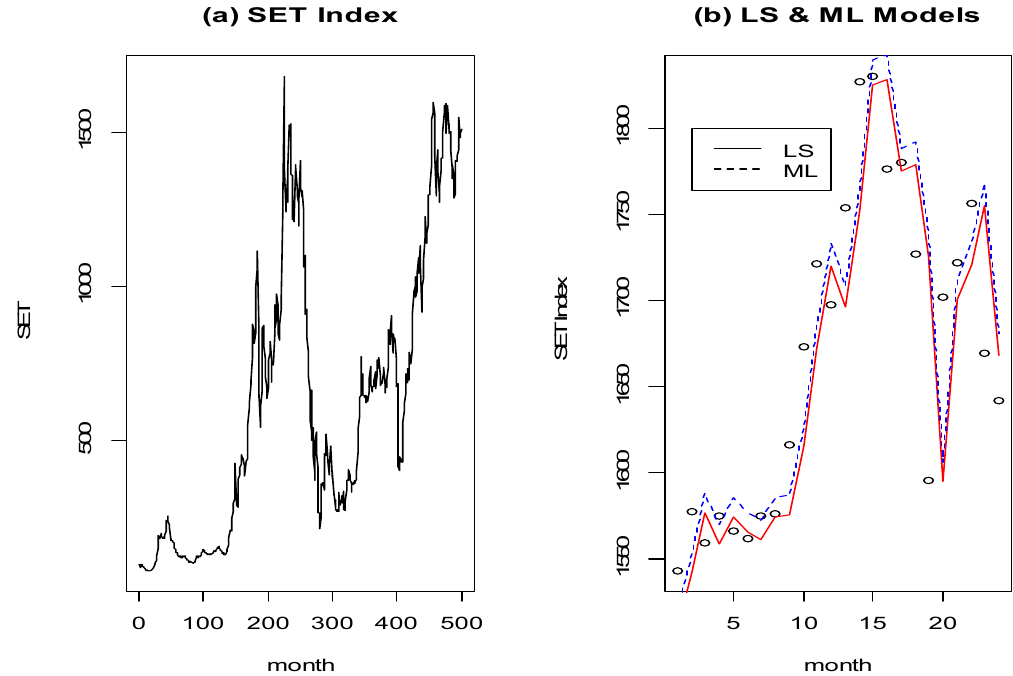
Figure 12. The time series plot for the Stock Exchange of Thailand (SET) index and the plot of SET index for forecasting of least squares (LS) vs maximum likelihood methods.